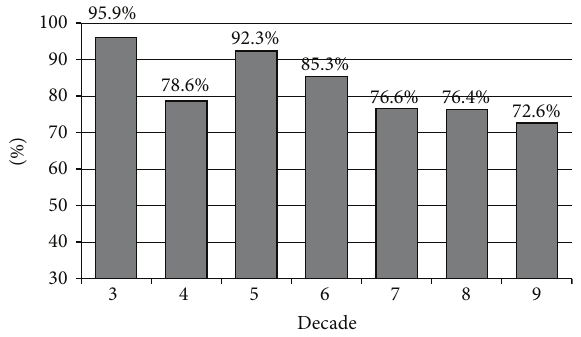
F 1: Percent of patients in each decade of life with a reliability